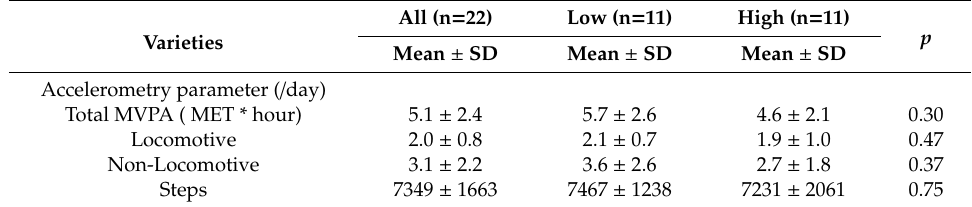
Table 2. Physical activity parameters for the whole study group and Low- and High-PWV groups